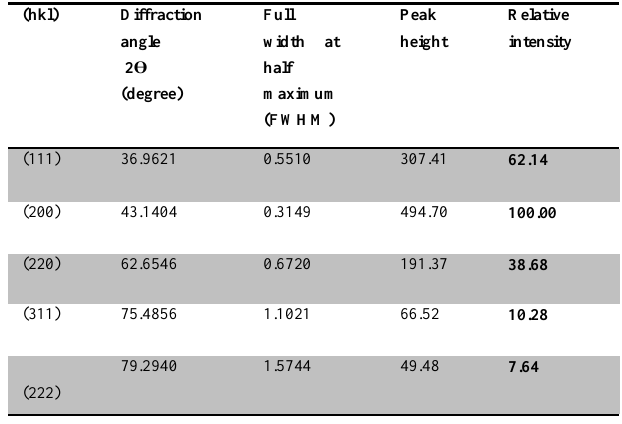
Data of X-ray diffraction (XRD) pattern from NiO nanoparticle after calcination.